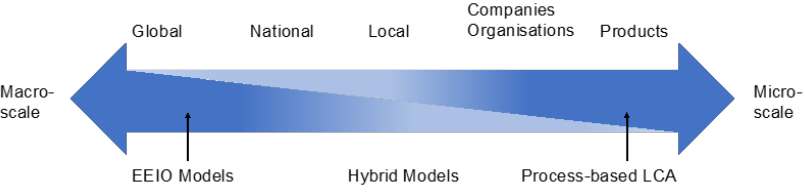
Figure 2. GHG assessment model types [14]. EEIO: environmentally extended input–output; LCA: life cycle